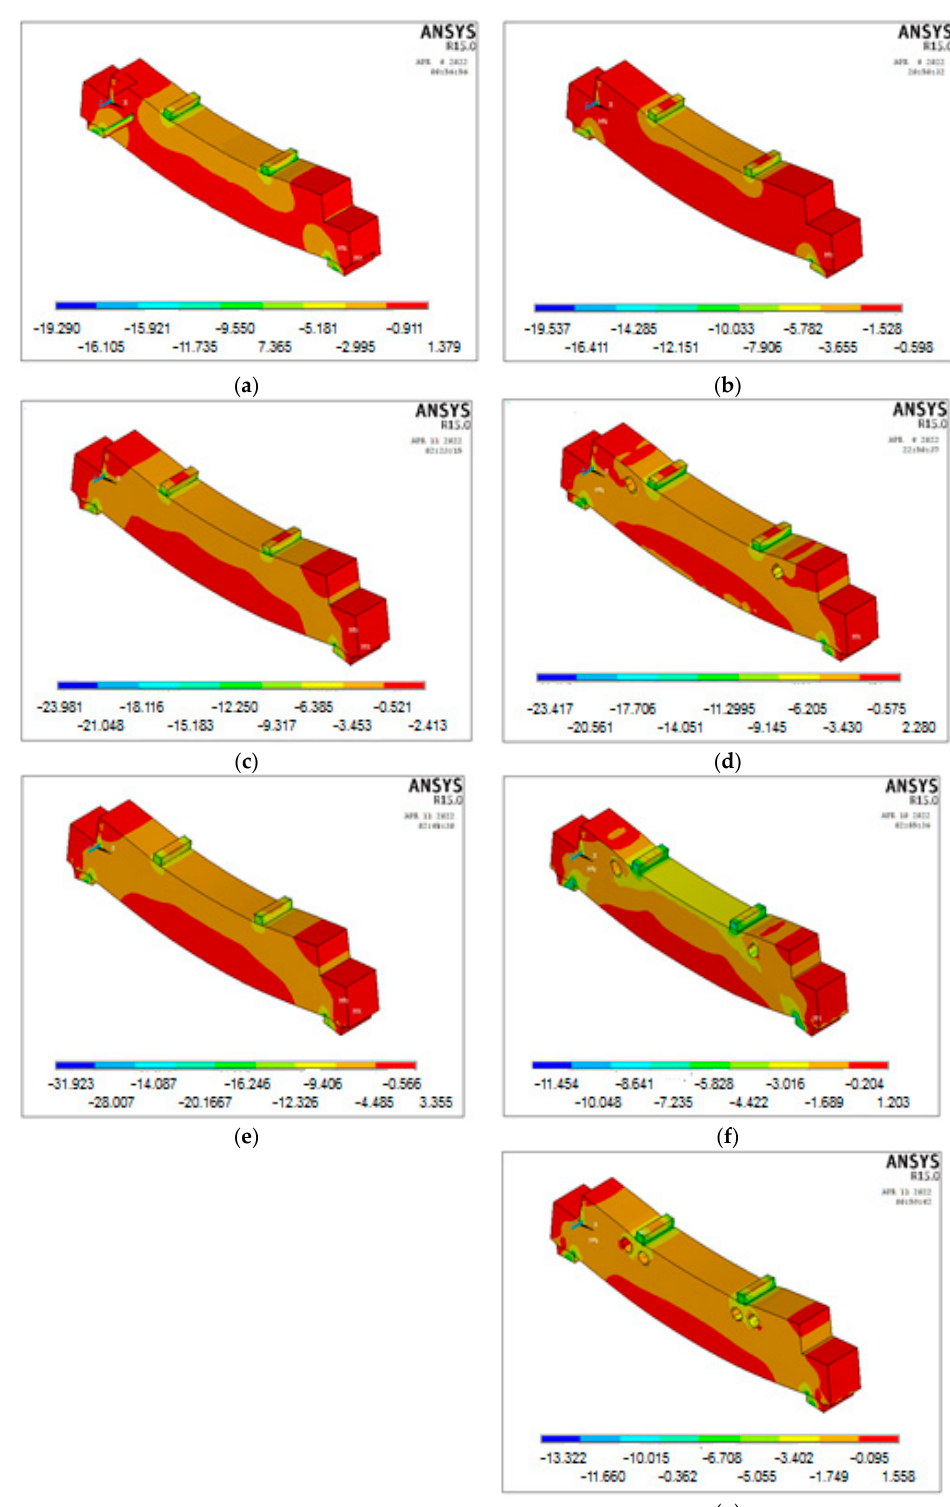
Figure 13. 3D contours of the hydrostatic stress distributions for all models. ( a ) DENT1. ( b ) DENT2. ( c ) DET3. ( d ) DET4. ( e ) DET5. ( f ) DET6. ( g ) DET7.